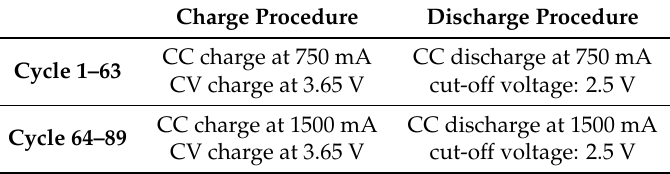
Table 1. Cycling